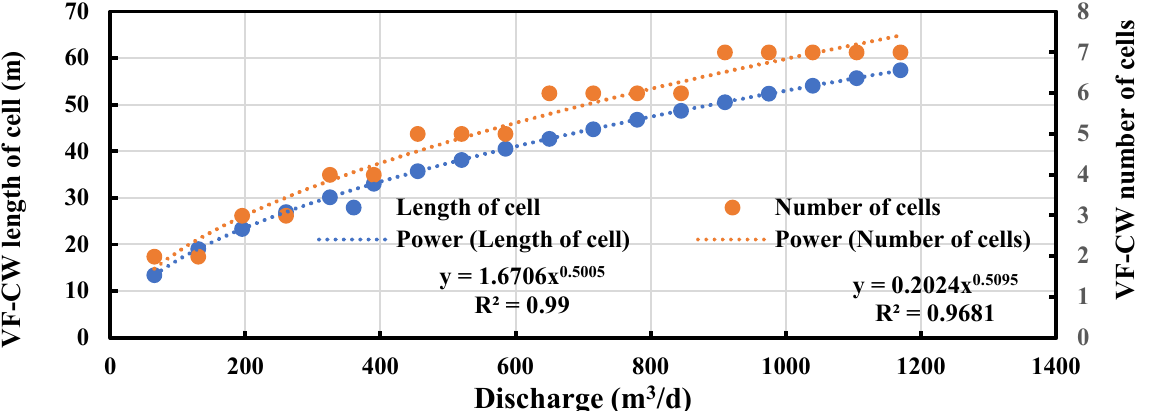
Figure 4. Design curves for HSSF-CW and VF-CW treatment systems: ( A ) HSSF-CW population equivalent area function, ( B ) HSSF-CW population equivalent, number of cells, and length of cell functions, ( C ) VF-CW population equivalent area, and ( D ) VF-CW population equivalent, number of cells, and length of cell functions. Table 5. HSSF-CW design dimensions for discharge range of 65–1170 m 3